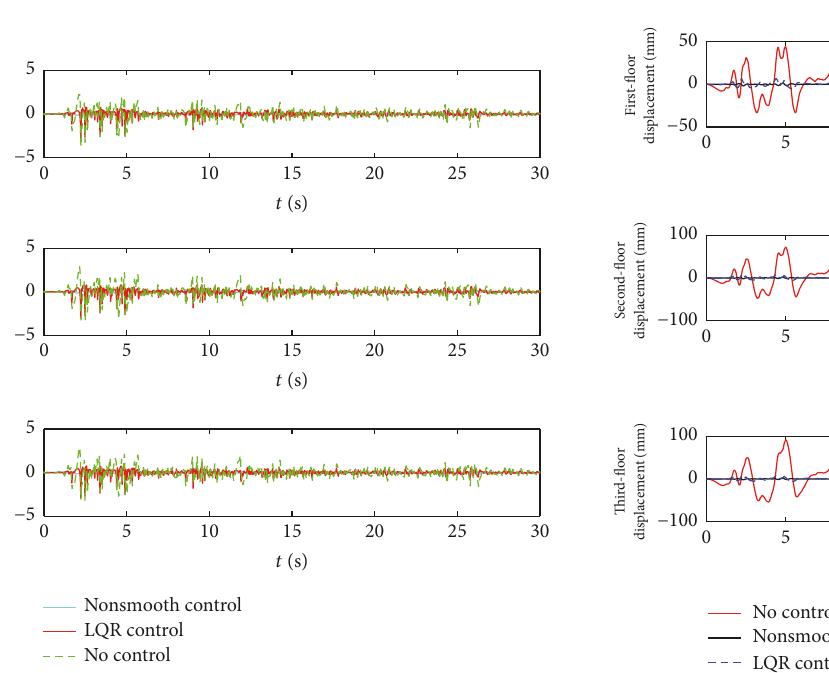
Figure 1: Control force of example 1.